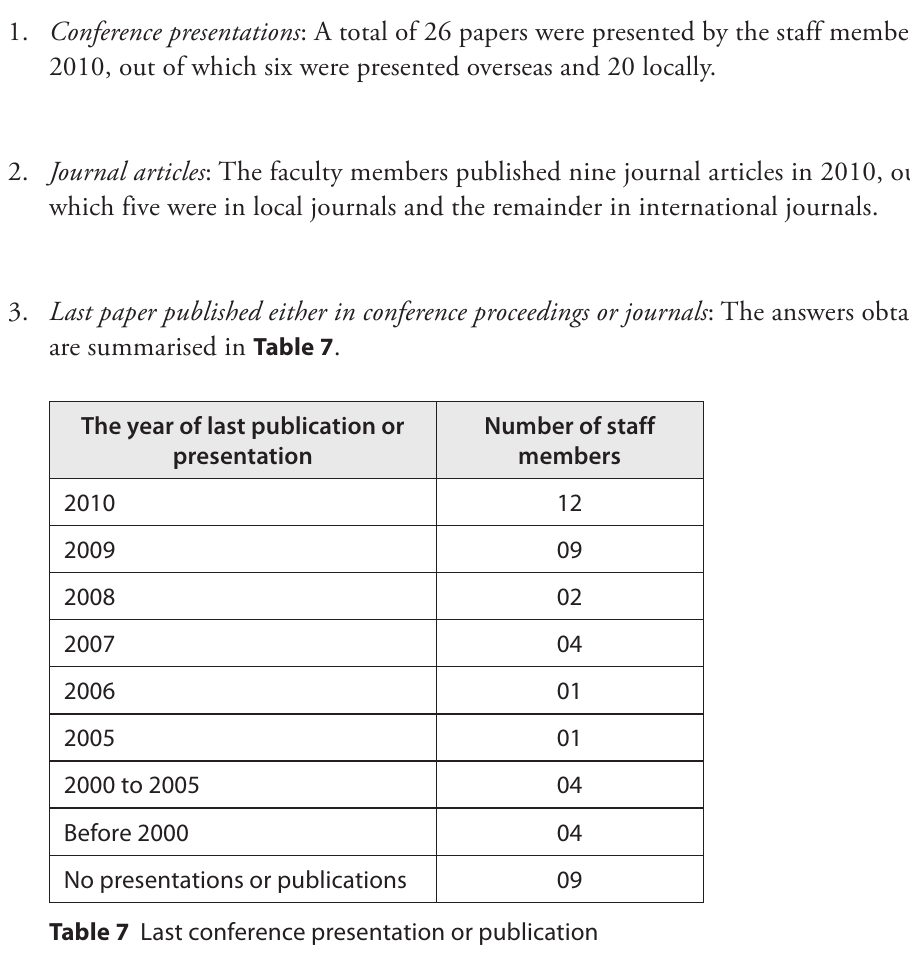
Out of the 44 respondents, nine (20.5 %) admitted that they had never published or presented a paper in any